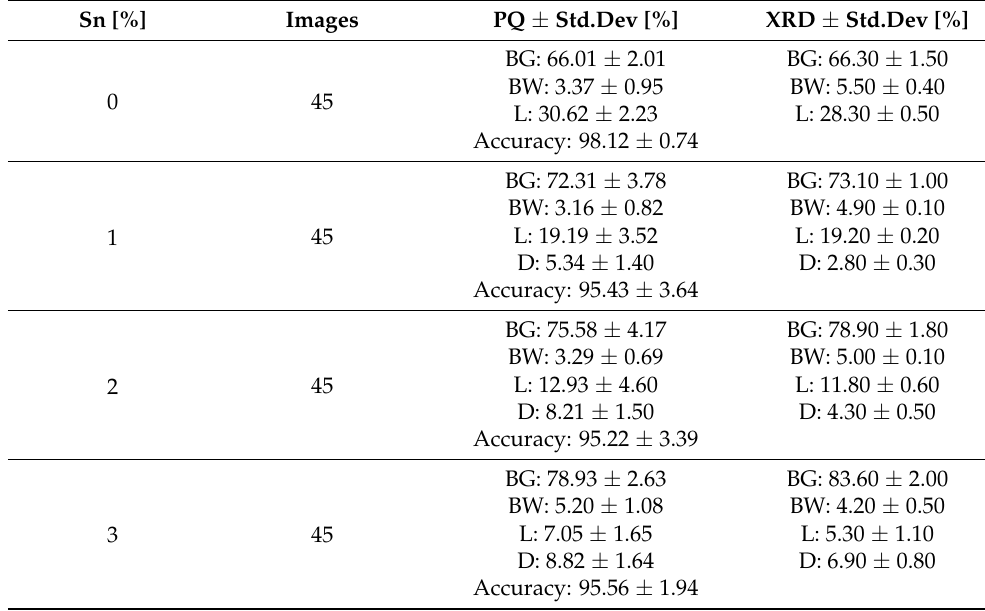
Table 9. Comparison of results with